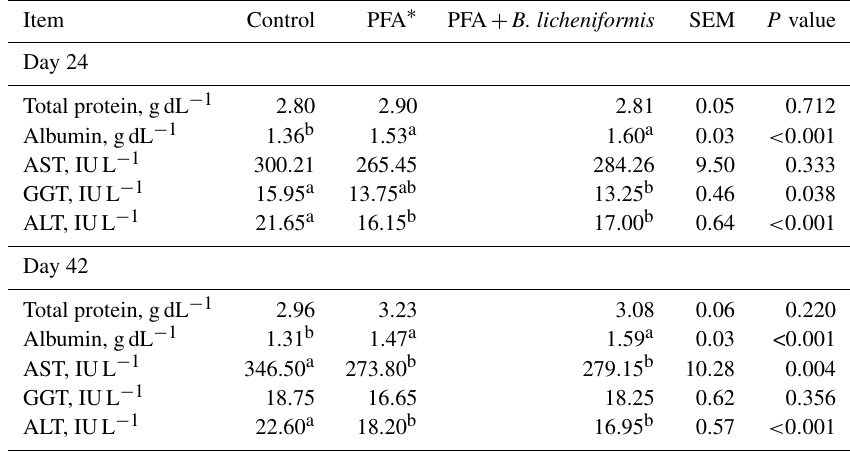
Table 5. Blood biochemistry of broiler chickens fed supplemental phytogenic feed additive alone or in combination with Bacillus licheni- formis . Item